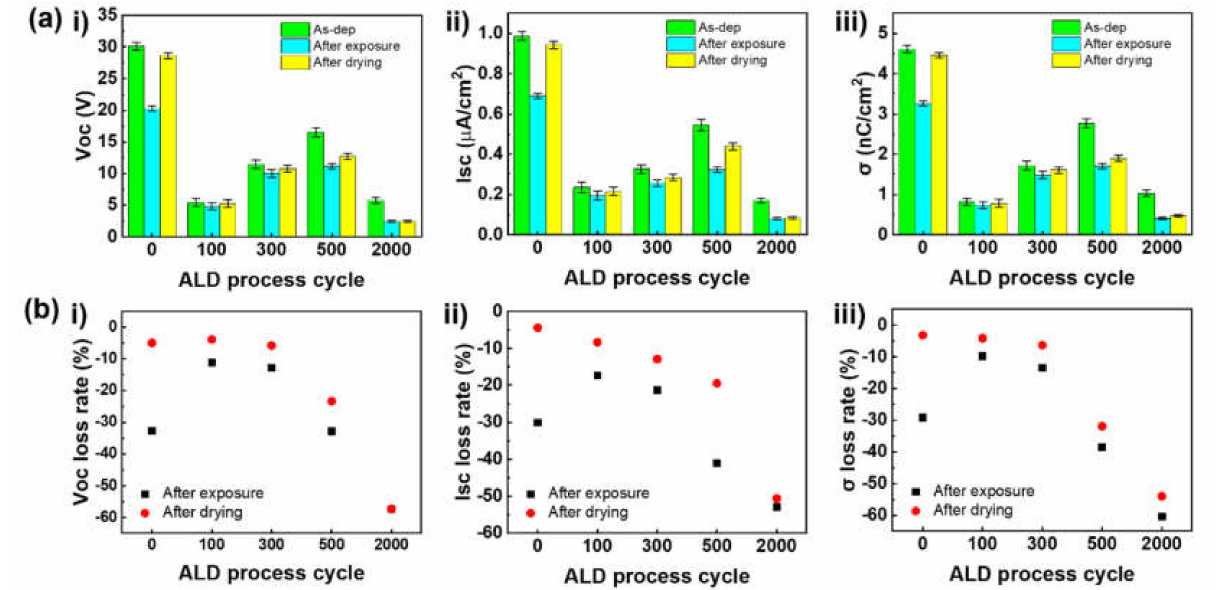
Figure 4. Effect of moisture on the triboelectric outputs of ALD-TiO x /PTFE films. ( a ) Comparison of triboelectric signals after moisture exposure and natural drying process. ( b ) Triboelectric signal loss rate of ALD-TiO x /PTFE films after moisture exposure and drying process as a function of ALD cycles; (i) open circuit voltage (V OC ), (ii) short circuit current (I SC ), and (iii) charge density ( σ